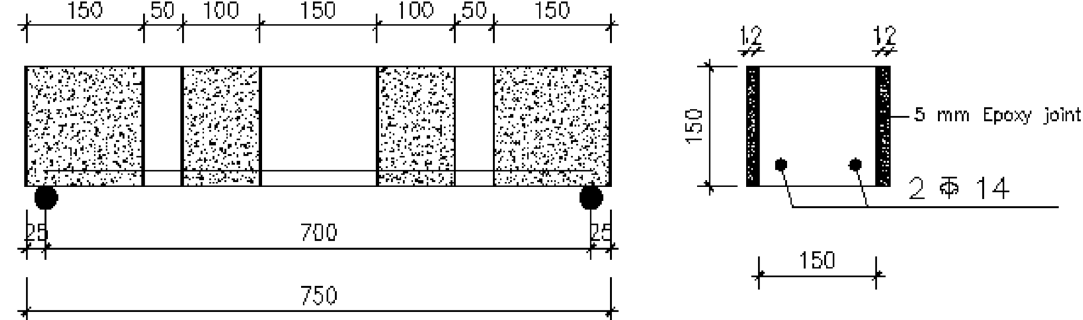
Fig. 6 Beam strengthened with vertical HPFRC strips (all dimensions in